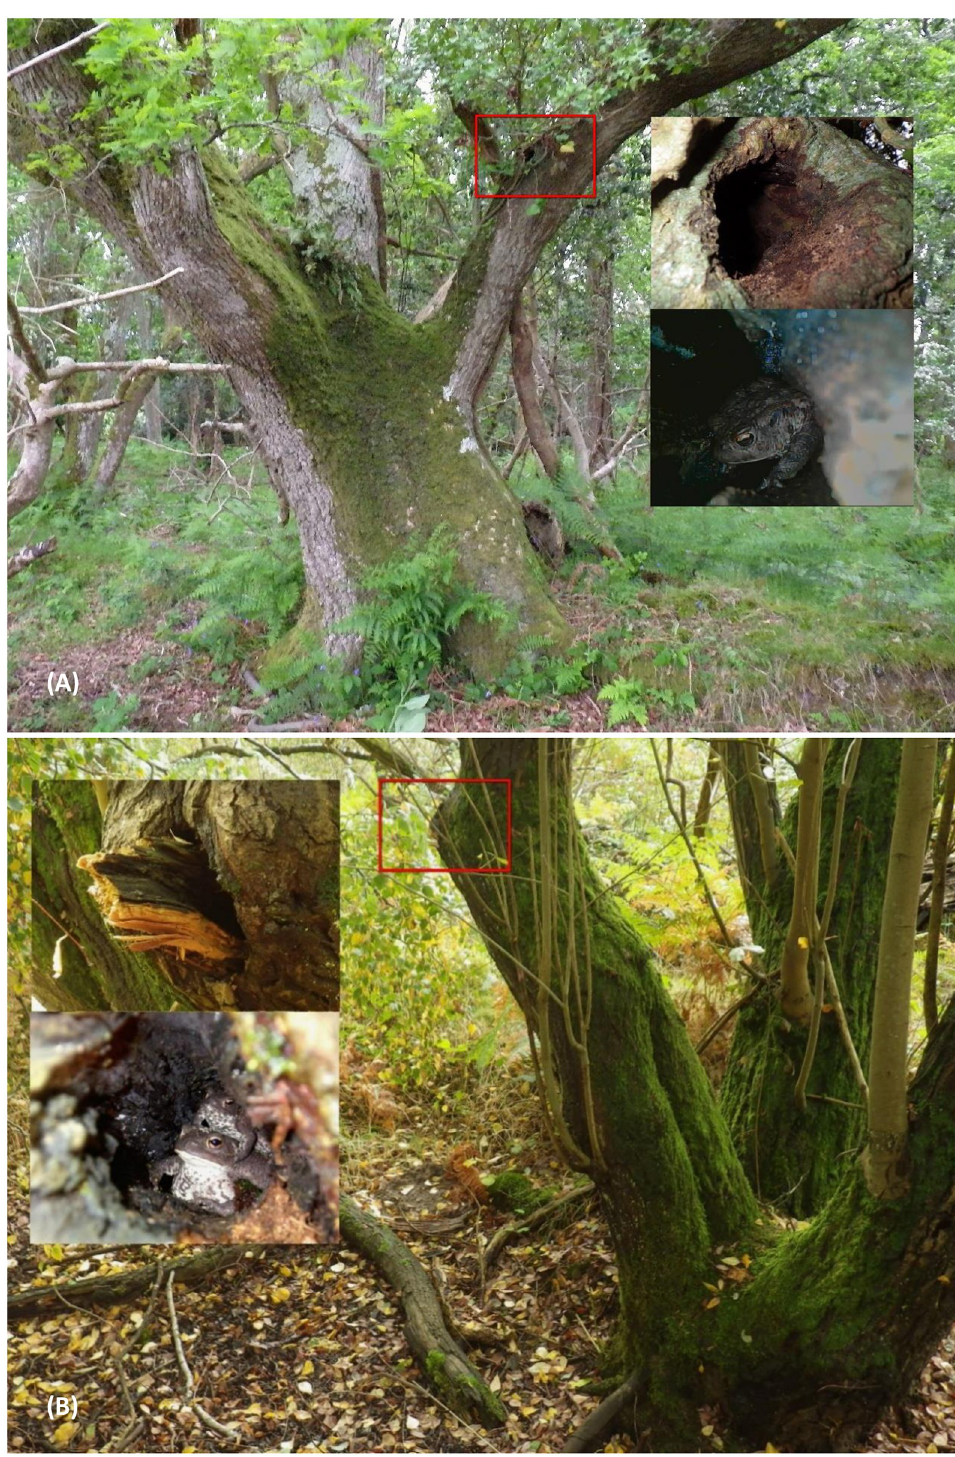
Fig 2. Total tree aspect, detail of PRF entrance and internal PRF image examples from BTHK. A the PRF (knot-hole type) is 2.8 m up the common oak and an adult toad, probably male, is visible in the endoscope image. B the PRF (tear- out type) is 0.93 m up the goat willow and two toads, an adult and a subadult are visible inside. Images Henry Andrews.